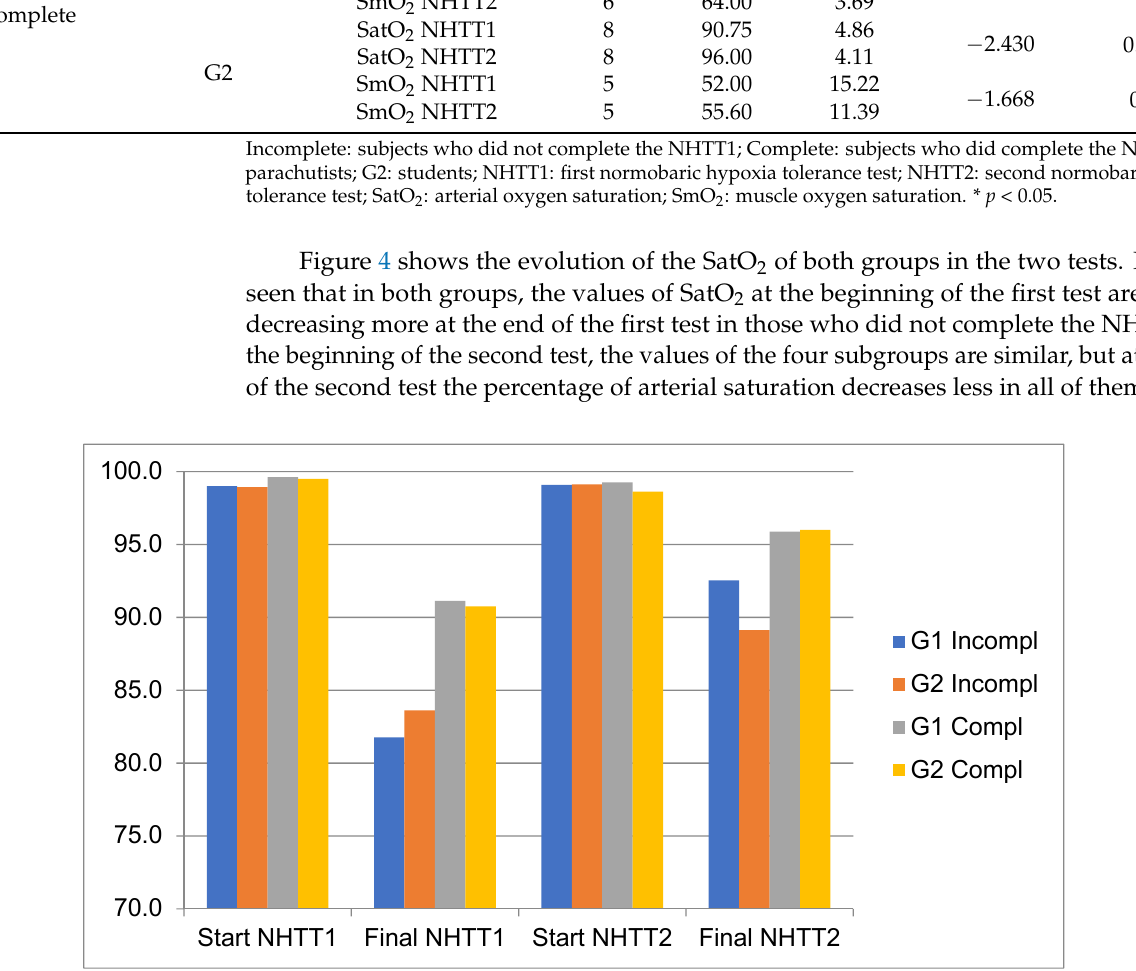
Figure 4. Evolution of SatO 2 (%) in both test and subgroups. NHTT1: first normobaric hypoxia tolerance test; NHTT2: second normobaric hypoxia tolerance test; G1 Incompl: group of parachutists with incomplete test; G2 Incompl: group of students with incomplete test; G1 Compl: group of parachutists with complete test; G2 Compl: group of students with complete